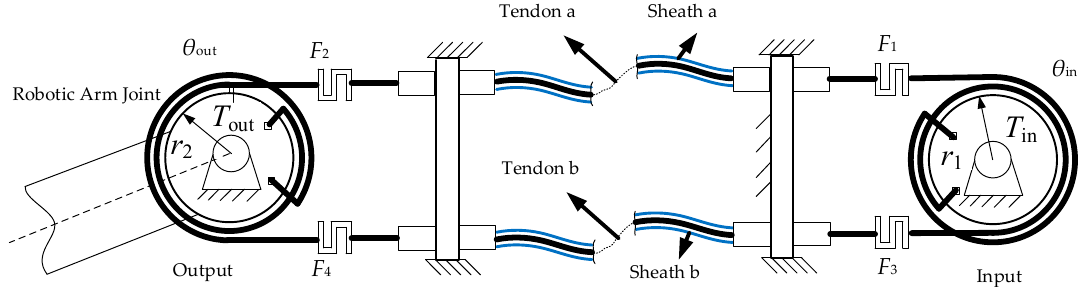
Figure 1. Model of the double tendon-sheath drive system.